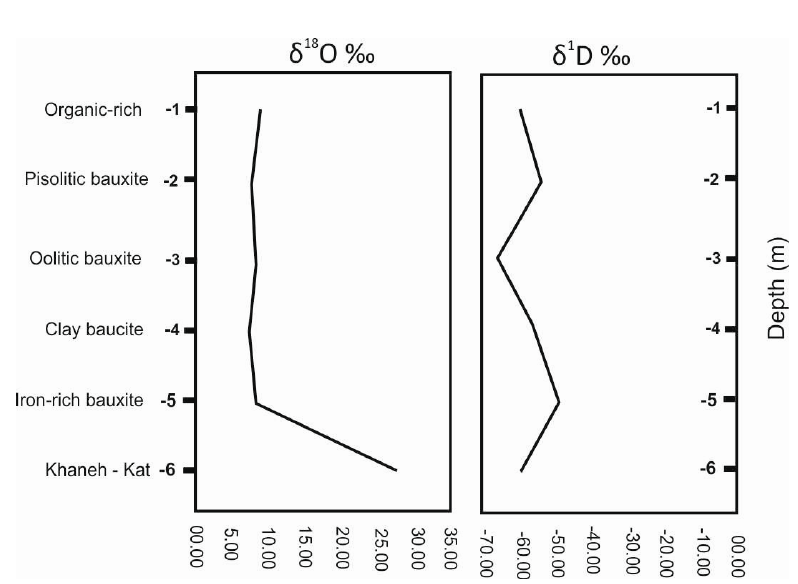
Figure 14. Vertical variation of the δ 18 O and δ D values of the Dopolan and the Khaneh–Kat